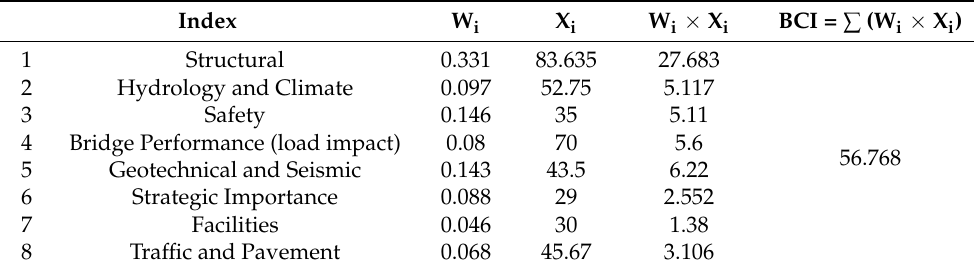
Table 22. BCI calculation of the bridge on 12th km of Semnan-Jandaq